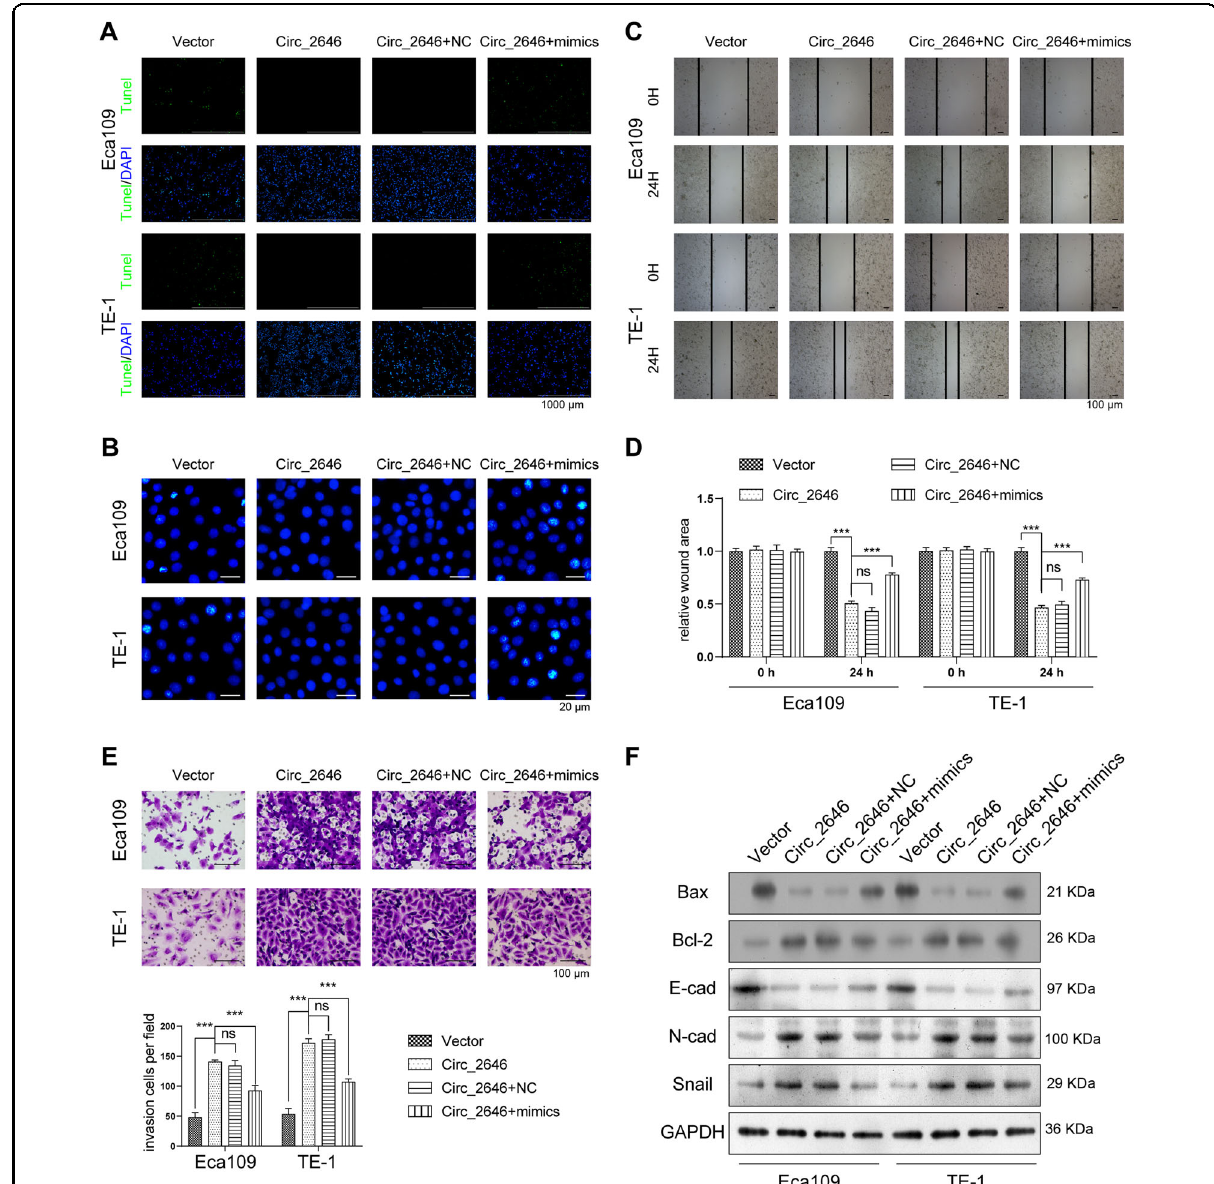
Fig. 3 CircRNA_2646 inhibited ESCC cell apoptosis and promoted metastasis via inhibiting miR-124. After overexpression of circRNA_2646 with or without miR-124 mimics transfection, the apoptosis of Eca109 and TE-1 cells were determined by A Hoechst staining, scale bars, 1000 μ m. B TUNEL assay, scale bars, 20 μ m. The ability of migration and invasion estimated by C , D scratch wound assay, scale bars, 100 μ m. E transwell assay, scale bars, 100 μ m. F The key proteins in apoptosis pathway and EMT pathway analyzed by Western Blot. *** p <